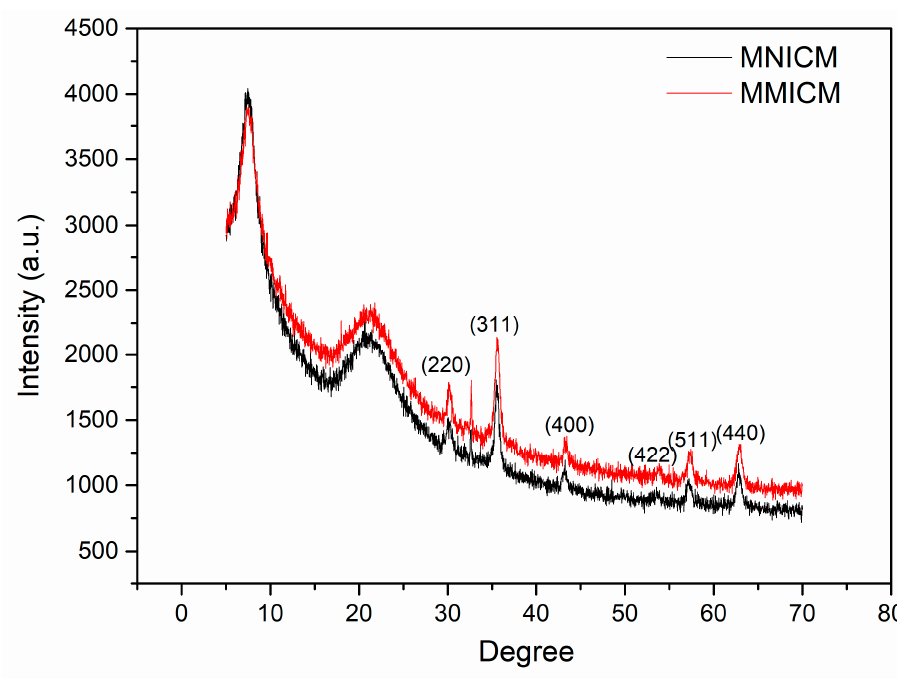
Figure 4. XRD patterns of the MNICM and